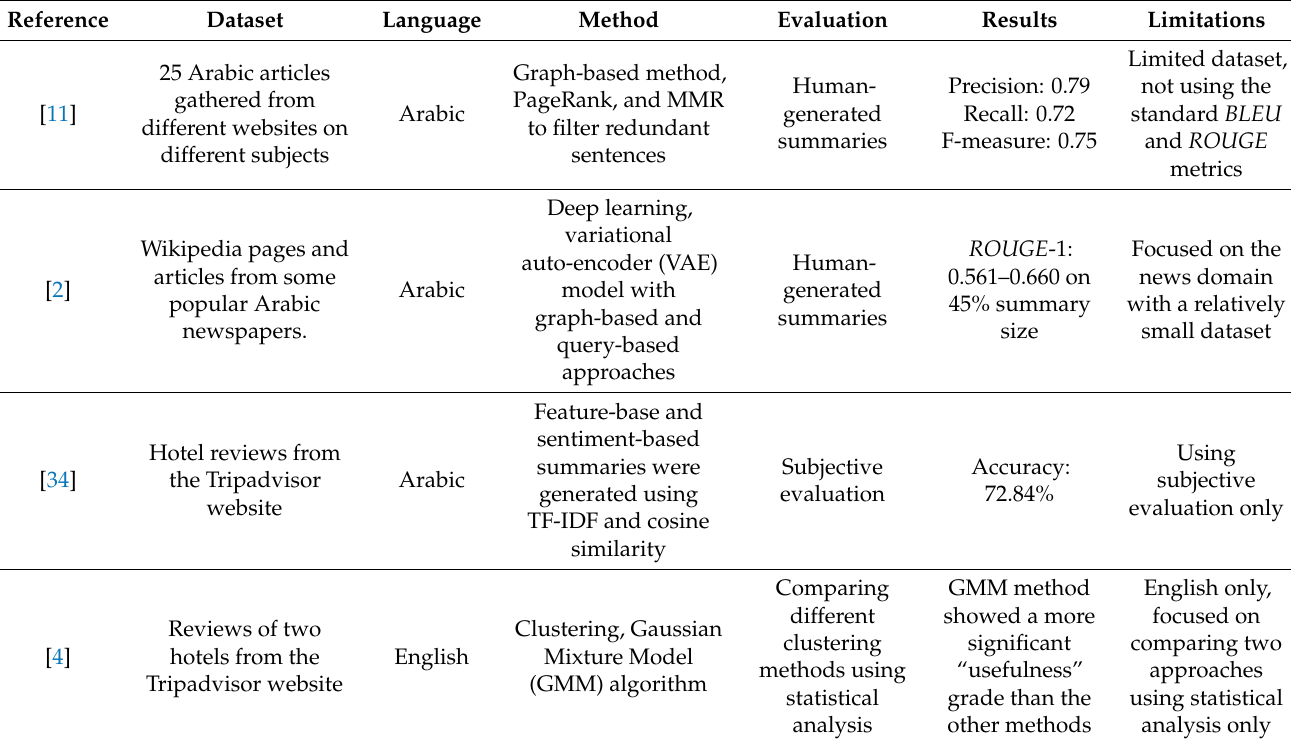
Table 1. Summary of selected extractive text summarization